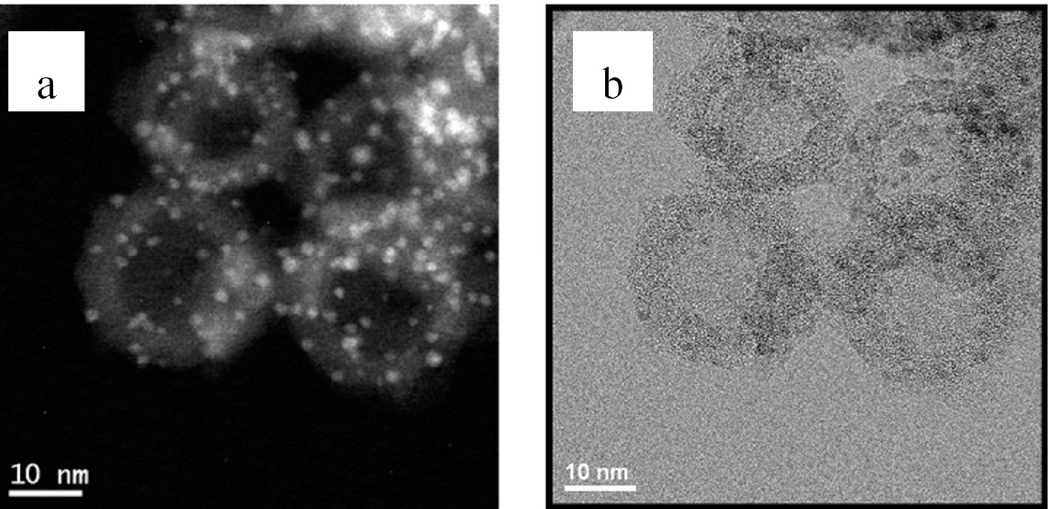
Figure 2. Transmission electron microscope (TEM) images of Pd cluster on silica core − shell nanospheres after removal of polymer particles: ( a ) Z-contrast; and ( b ) bright-field. “Reproduced with permission from [50], American Chemical Society, 2014.” [50]).